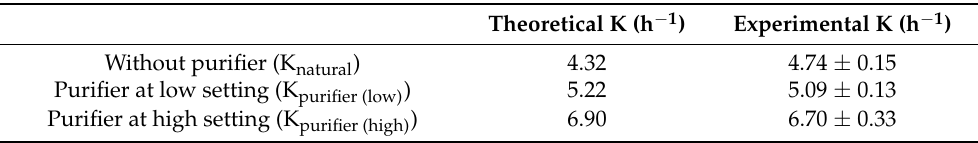
Figure 5. Decay rate curves with and without the use of purifier at different flow rates based on ( a ) PM and ( b ) PN in classroom 3. The dotted curves represent exponential trendlines. Table 3. Theoretical versus experimental decay rates for particle mass (PM) with and without the use of purifier at different settings in classroom 3.